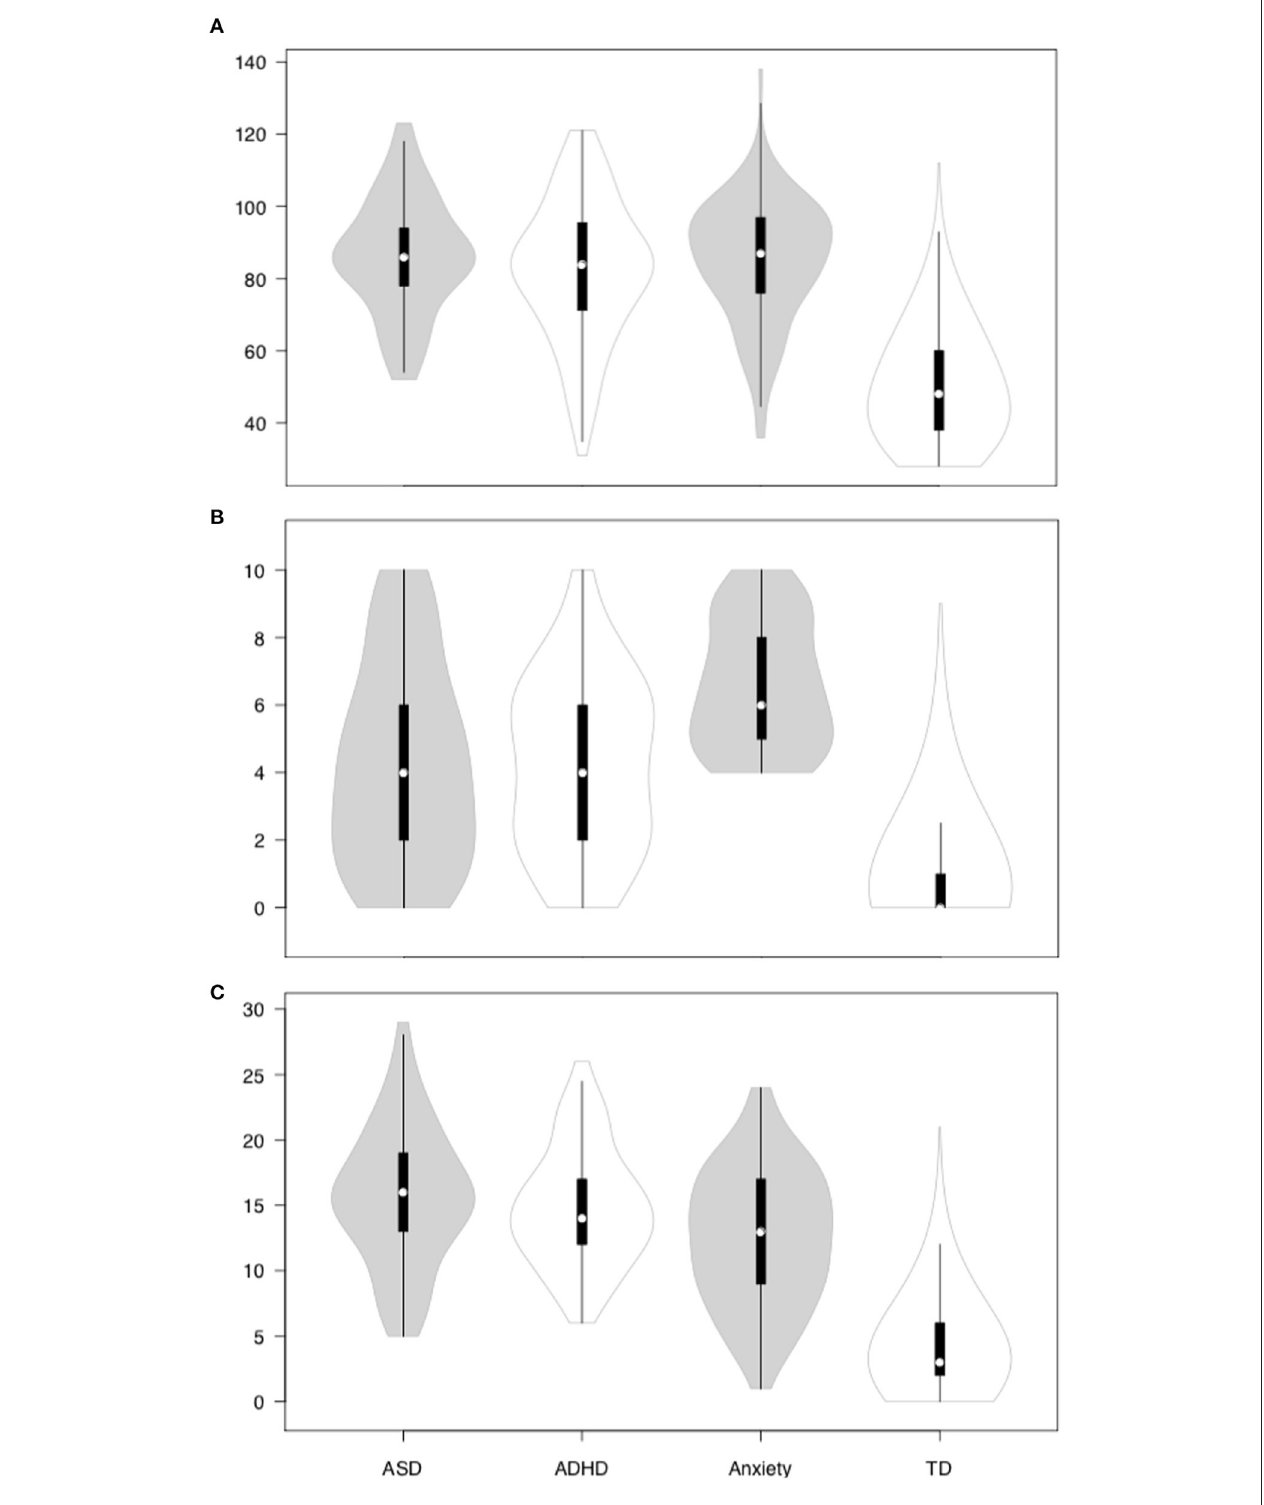
FIGURE 1 | DERS, internalizing and externalizing symptoms across the clinical and non-clinical subgroups. (A) DERS; (B) internalizing symptoms; (C) externalizing symptoms.